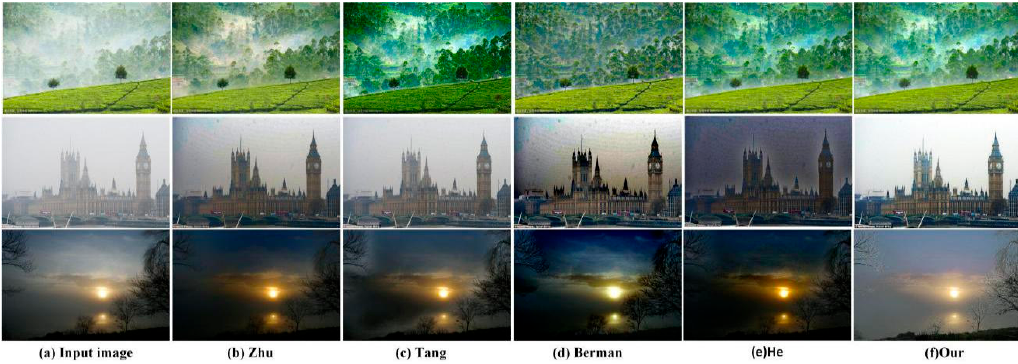
Figure 12. A comparison of color preservation.